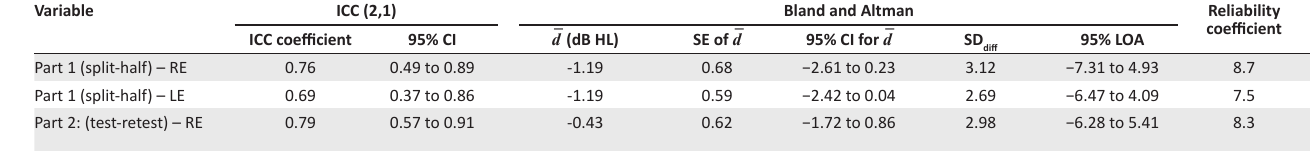
TABLE 2: Intraclass correlation coefficients (2,1) and Bland and Altman tests for parts 1 (internal consistency) and 2 (external consistency) of the study. Variable ICC